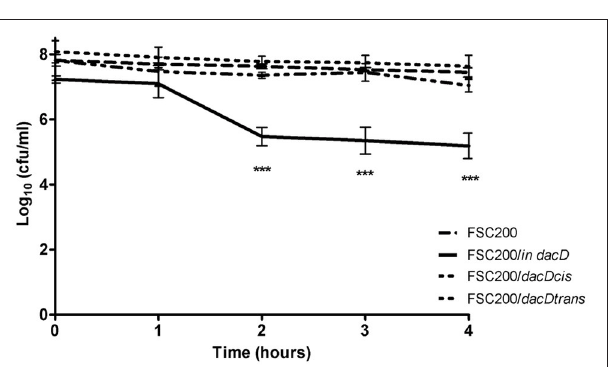
FIGURE 6 | SDS survival assay . F. tularensis strains were cultivated in CHM and when the strains reached the OD 600 = 1, the SDS was added and the numbers of CFU were enumerated at indicated time intervals. *** P <